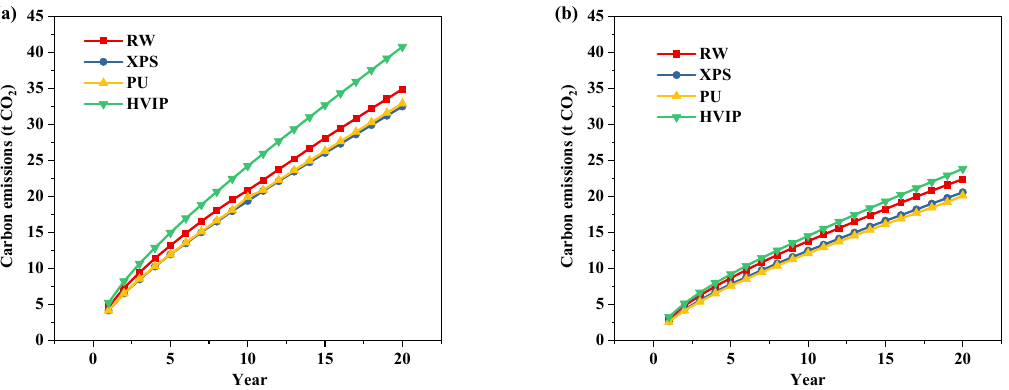
Figure 10. Carbon emissions corresponding to the economic thickness ( a ) 2177.5 m; ( b ) 950 m.